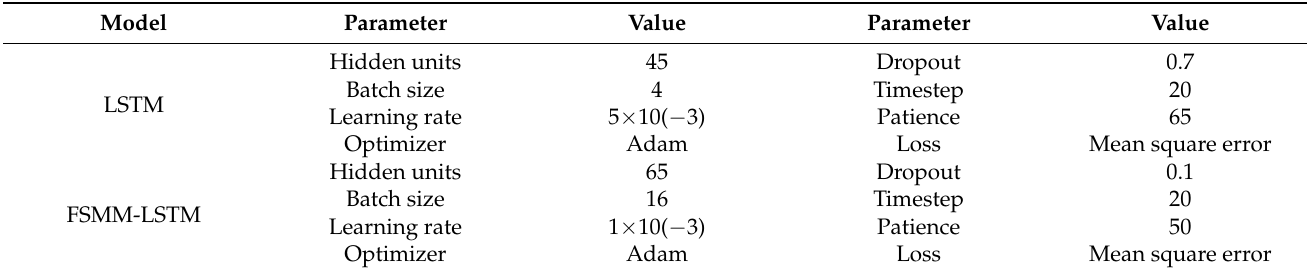
Table 2. Training hyperparameters for the LSTM network and FSMM-LSTM